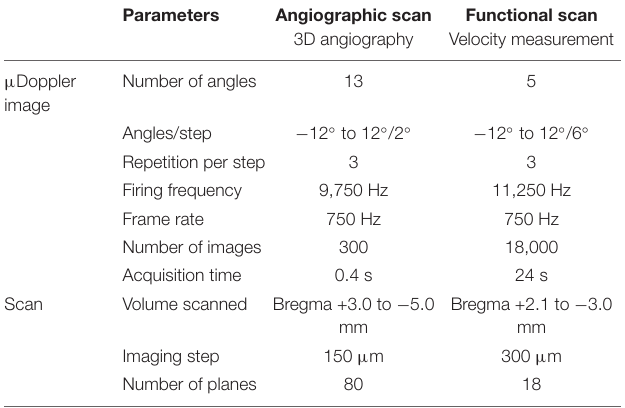
TABLE 1 | Parameters of angiographic and functional scans. Parameters Angiographic scan 3D